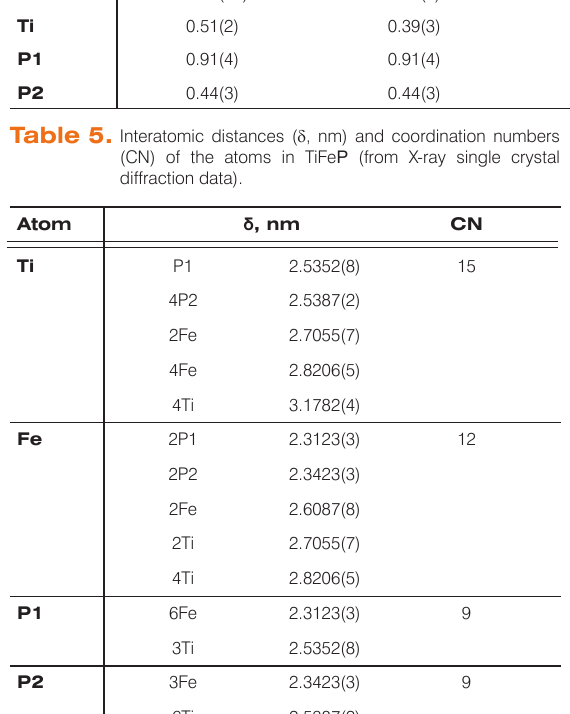
Interatomic distances ( δ , nm) and coordination numbers (CN) of the atoms in TiFe Р (from X-ray single crystal diffraction